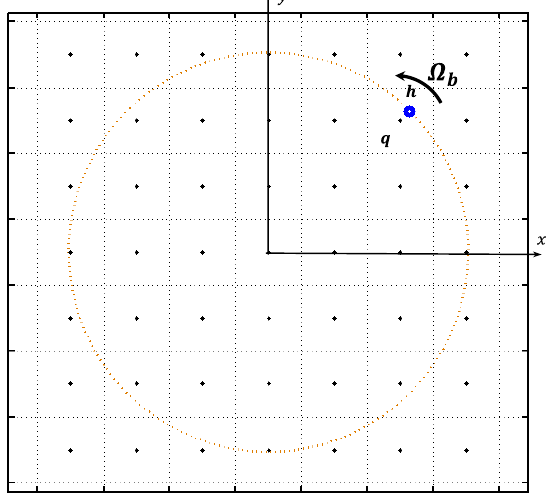
Figure 4. Schematic of a cross-sectional view of the actuator line in the computational